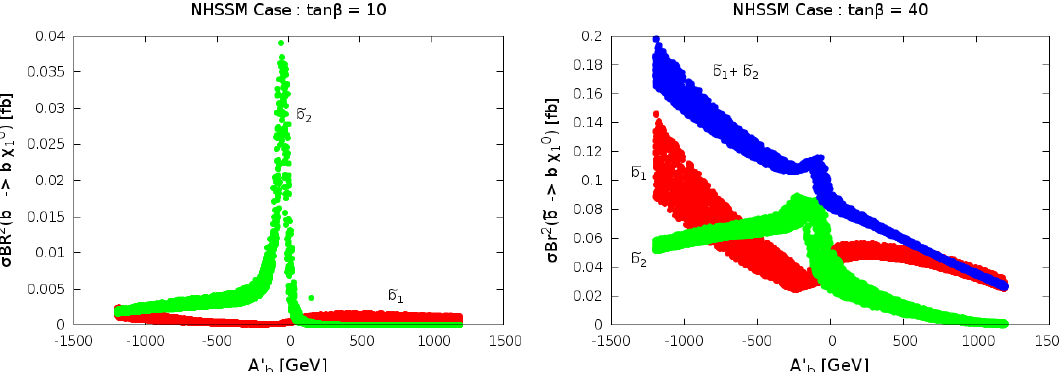
(cid:12)nal state arising from ~ b 1 (in red) and 1 0 . The left (right) panel stands b